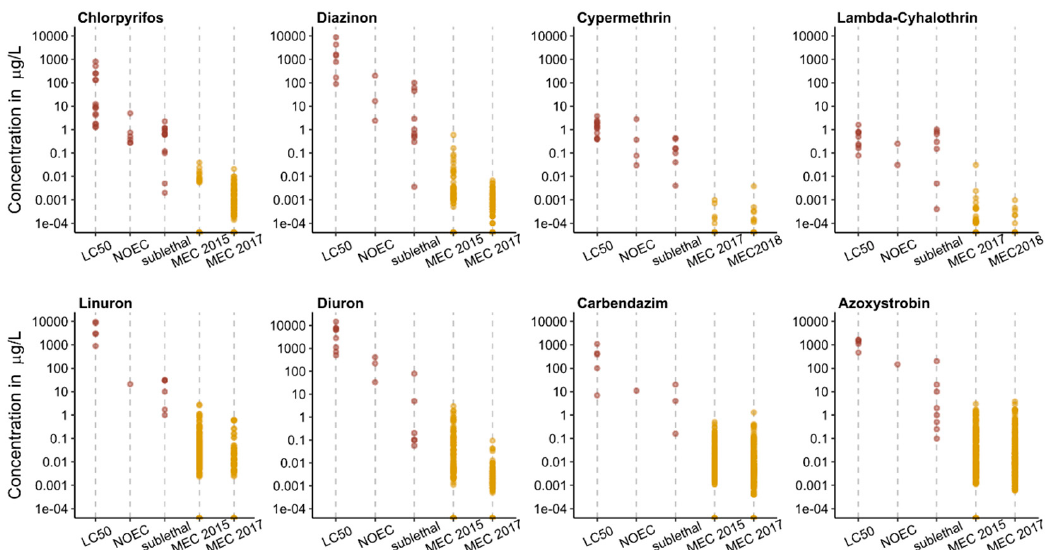
Figure 3. Comparison of LC 50 ′ s, no observed effect concentrations for apical sublethal endpoints (NOEC) and selected non-apical sublethal effect concentrations (sublethal) in red, with maximum environmental concentrations (MEC; in orange) measured in Switzerland in 2015 (0.5–24 day TP composite samples, [5]), 2017 (3.5 day TP composite samples, [6,7]) and 2018 (14 day TP composite sample, [7]). Values < LOQ were substituted with zero; 2017 MEC for chlorpyrifos from [7]. References are provided in SI, Table S7.